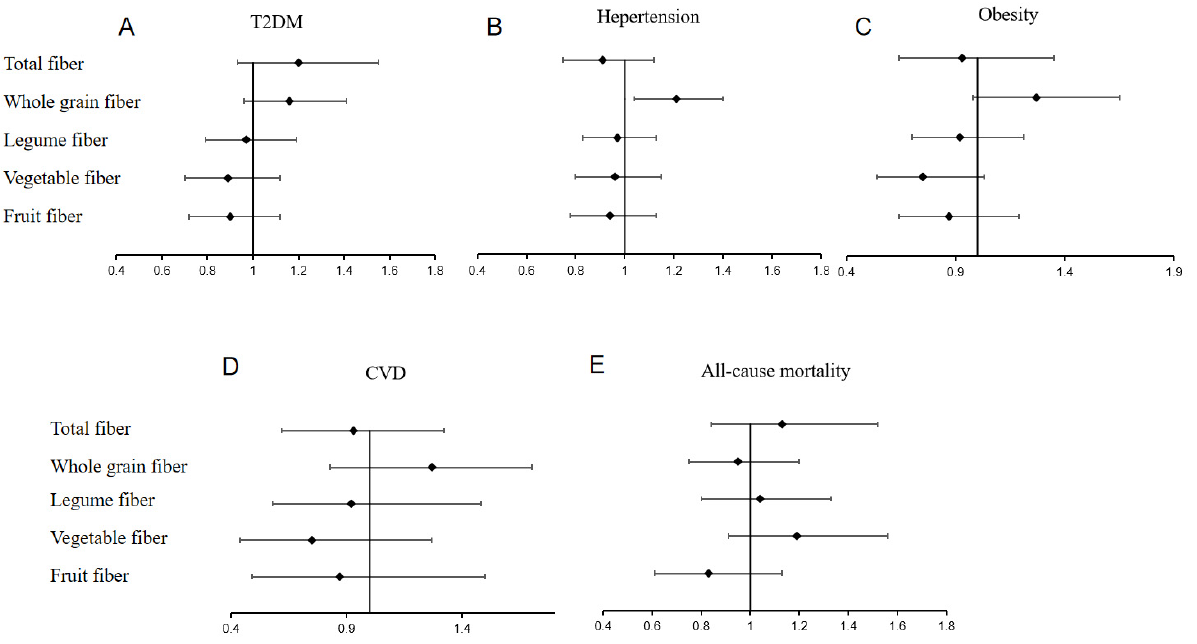
Figure 2. Associations between the consumption of dietary fibers from different sources and ( A ) T2DM, ( B ) hypertension, ( C ) obesity, ( D ) CVD, ( E ) mortality from all causes. Table 2. Multi-variable adjusted HRs (95% CI) of T2D, hypertension, obesity, CVD, and all-cause mortality according to quartiles of total dietary fiber. The whole-grain fiber intake was divided into terciles (T1–T3). In the cohort of T2D, hypertension, obesity, CVD and all-cause mortality, the HR T3 vs. T1 were 1.31 (95% CI: 1.09, 1.57), 1.29 (95% CI: 1.13, 1.47), 1.62 (95% CI: 1.28, 2.05), 1.43 (95% CI: 0.97, 2.12), and legume fiber on the basis of the adjustment for multiple factors of total dietary